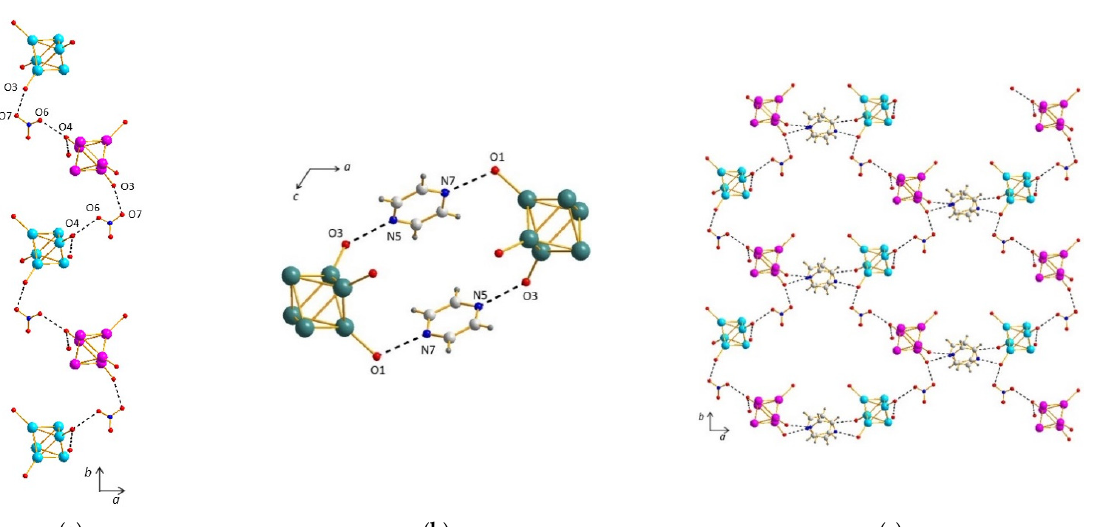
Figure 5. ( a ) Infinite chains of clusters bridged by nitrate groups along the b axis in the structure of ( 3 ). ( b ) Strong H bonding involving free pyrazine molecules leading to interchain connectivity and formation of dimers in the structure of ( 3 ). ( c ) Infinite sheet in the ( ab ) plane resulting from H bonds involving pyrazine molecules and nitrate bridges in the structure of ( 3 ).